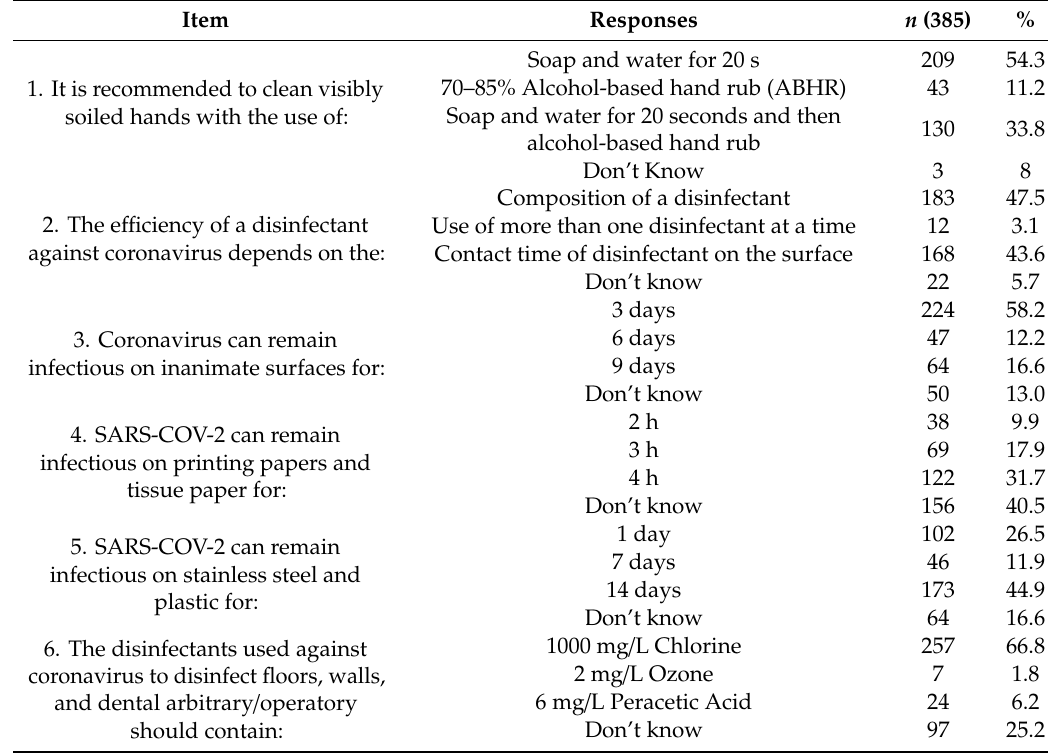
Table 2. Knowledge of the participants regarding disinfection against severe acute respiratory